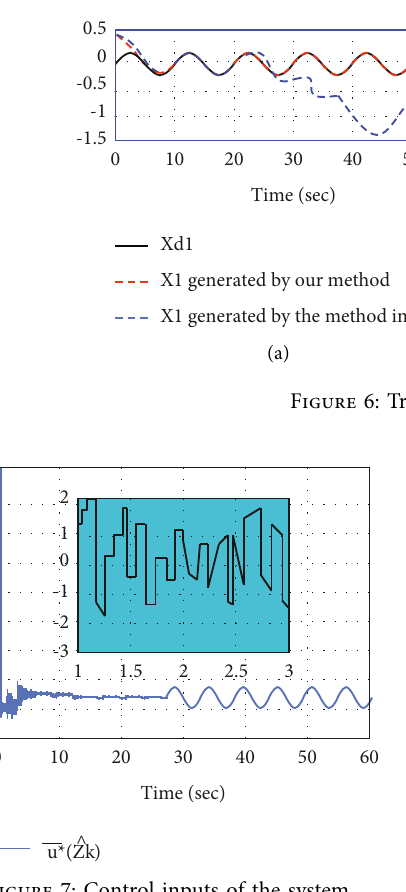
Figure 7: Control inputs of the system.